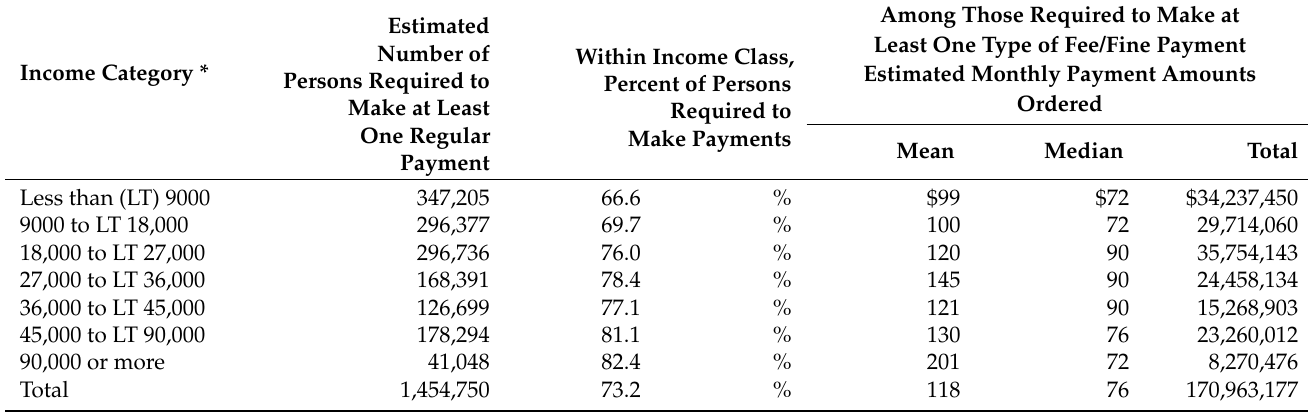
Table 2. Estimated number (weighted counts) of persons on probation required to make payments and weighted estimated amounts of payments, by income class, in current